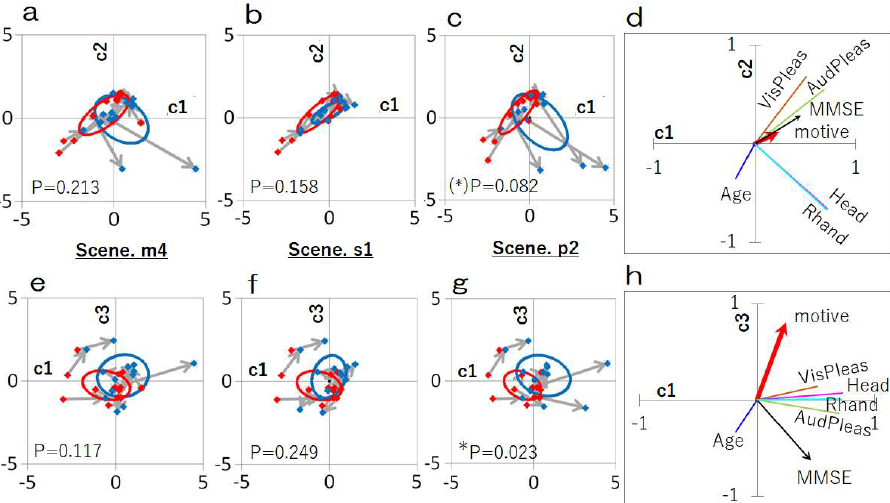
Figure 4. PCA by correlation matrix revealed distribution pattern shifts from Day 1 to Day 2. Gray arrowed vectors display shifts from Day 1 (red) to Day 2 (blue). Ellipses represent the group mean center with covariance axes calculated by PCA variance-covariance matrix in the 1st–2nd component dimensions ( a–d ), or 1st–3rd component dimensions ( e–h ). Three scenes comparison; ( a,e ) Scene m4: Motion reactive scene, ( b,f ) Scene s1: Sound reactive scene, ( c,g ) Scene p2: Not reactive, ( d,h ). Synthesized factor loading vectors project from the mean center. An asterisk denotes MANOVA (Wilks’ lambda) probability comparison between Day 1 and Day 2 is significant ( p < 0.05).